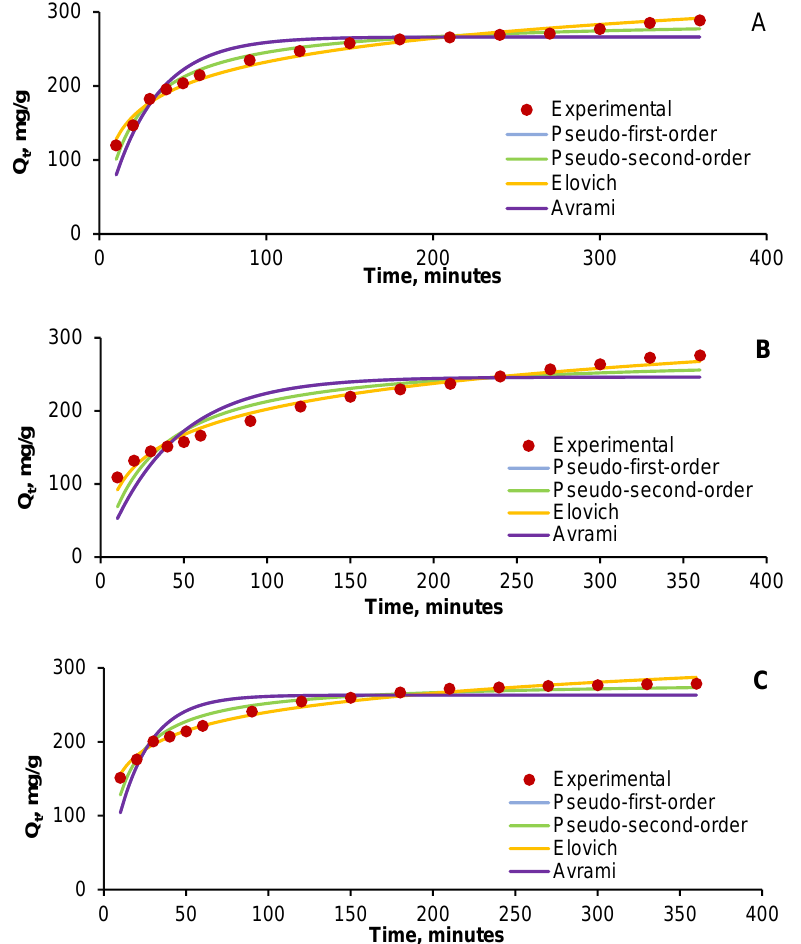
Figure 7. Kinetics of AR ( A ), RB ( B ), and 50% AR + 50% RB ( C ) adsorption on CSCH adsorbent.